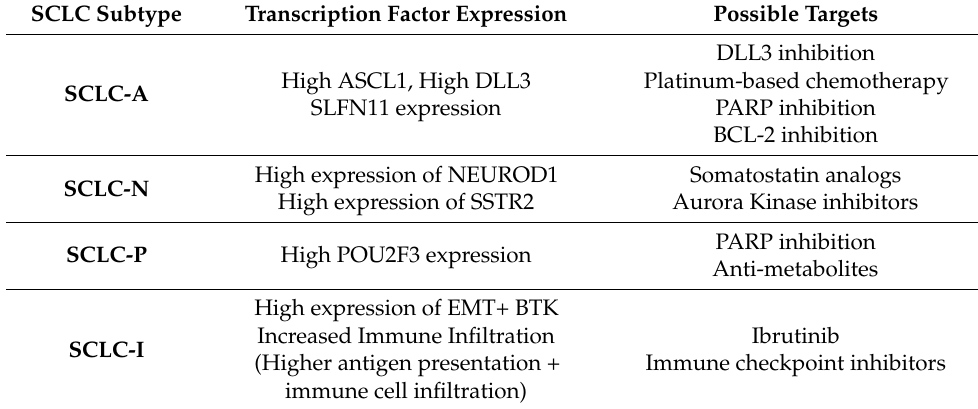
Table 1. SCLC subtypes, key transcription factors, and possible therapeutic approaches. SCLC